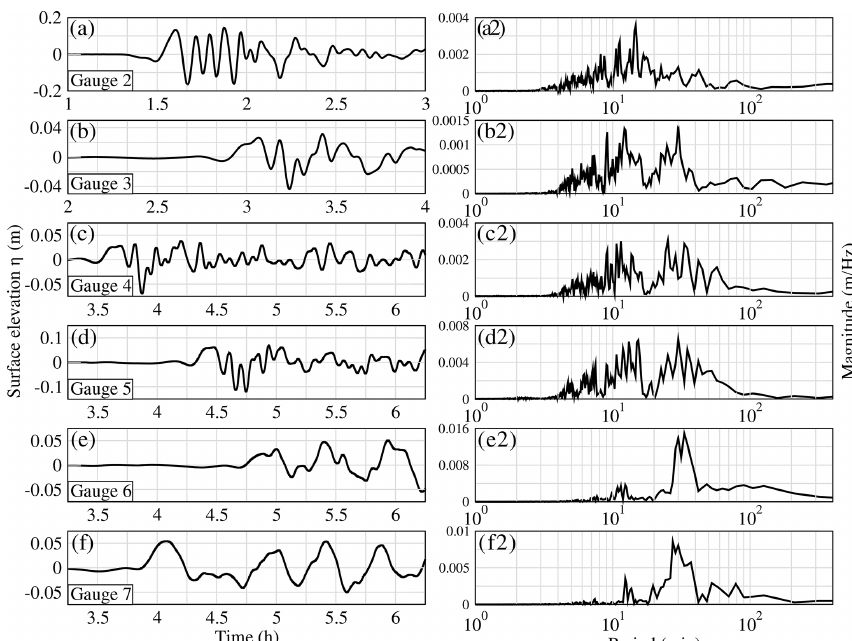
Figure 18. Surface elevations (m) (left column) and Fourier transforms (right column) for the 20km 3 scenario at Gauge 2 in southern Portugal ( a and a2 ), Gauge 3 in the abyssal plain of the Bay of Biscay ( b and b2 ), Gauge 4 on the continental shelf of the Bay of Biscay ( c and c2 ), Gauge 5 in southern Brittany ( d and d2 ), Gauge 6 in the Gironde estuary ( e and e2 ) and Gauge 7 in Saint-Jean-de-Luz ( f and f2 ) computed by FUNWAVE-TVD. The time takes into account the first 20min of the slide and tsunami generation.